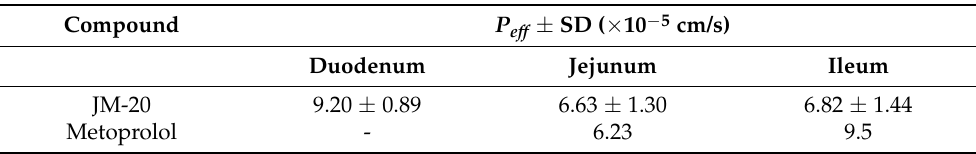
Table 4. Effective permeability coefficients ( P eff ) and absorption rate coefficient values for JM-20 using in situ rat intestinal perfusion